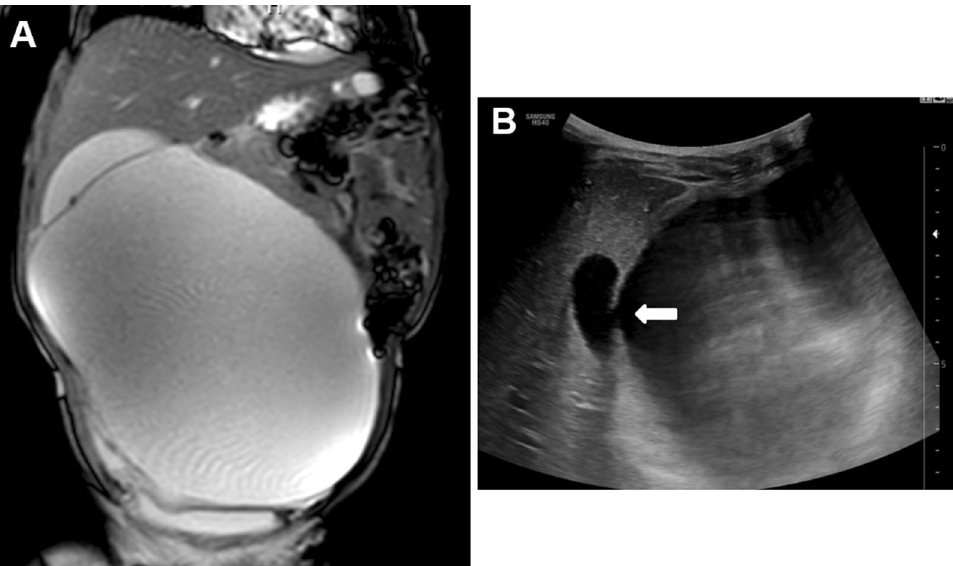
Fig. 5 A 2‑year‑old boy with ventriculo‑gallbladder shunt presented with increasing abdominal girth. A Coronal abdomino‑pelvic T2 SPIR and B corresponding ultrasound show a large abdomino‑pelvic loculated fluid (CSF pseudocyst) with gallbladder mural defect (arrow) demonstrated in ultrasound